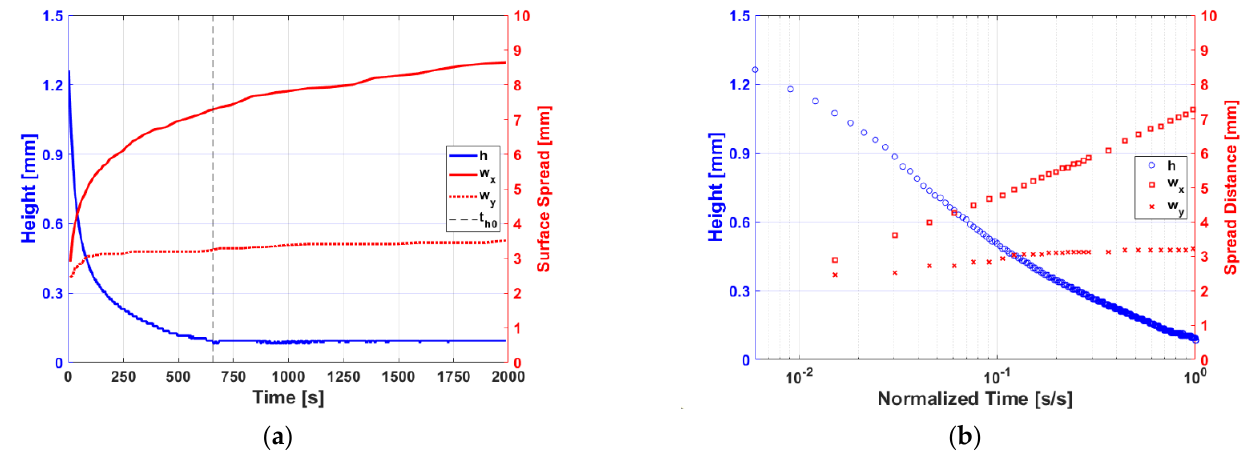
Figure 6. ( a ) Results from depositing 30 Pa·s viscosity fluid on fabric C. The left y -axis shows results derived from the side view, while the right y -axis shows results from top-down view. ( b ) Same results as ( a ), with time scale normalized to 𝑡 ℎ0 .